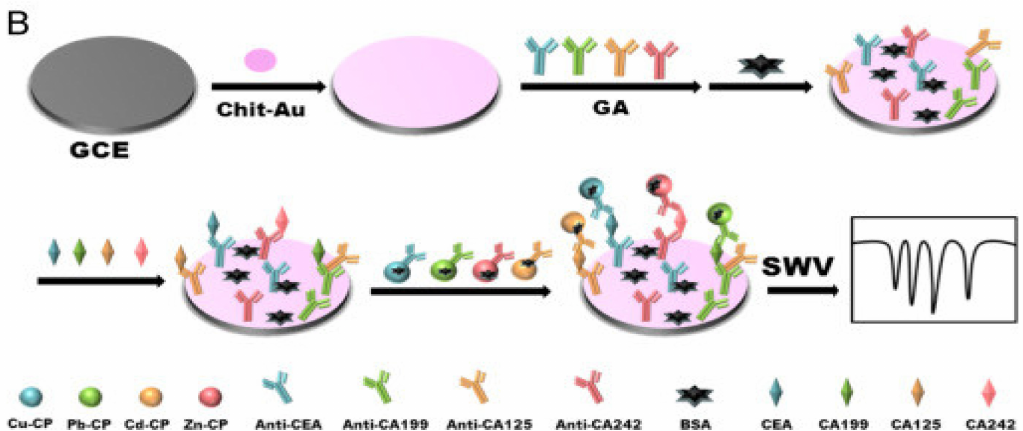
Figure 28. Preparation procedure of Cu–CP–anti–CEA, Pb–CP–anti–CA199, Cd–CP–anti–CA125 and Zn–CP–anti–CA242 immunosensing probes ( A ) and the fabrication steps involved in the sandwich–type immunosensor ( B ). CP: chitosan–poly (acrylic acid) nanospheres; Cu-CP: Cu doped with chitosan–poly (acrylic acid) nanospheres; Pb-CP: Pb doped with chitosan–poly (acrylic acid) nanospheres; Cd-CP: Cd doped with chitosan–poly (acrylic acid) nanospheres; GA: glutaraldehyde; chit-Au: chitosan–decorated AuNPs; SWV: square wave voltammetry. Reprinted with permission from [165], published by Elsevier, 2016.